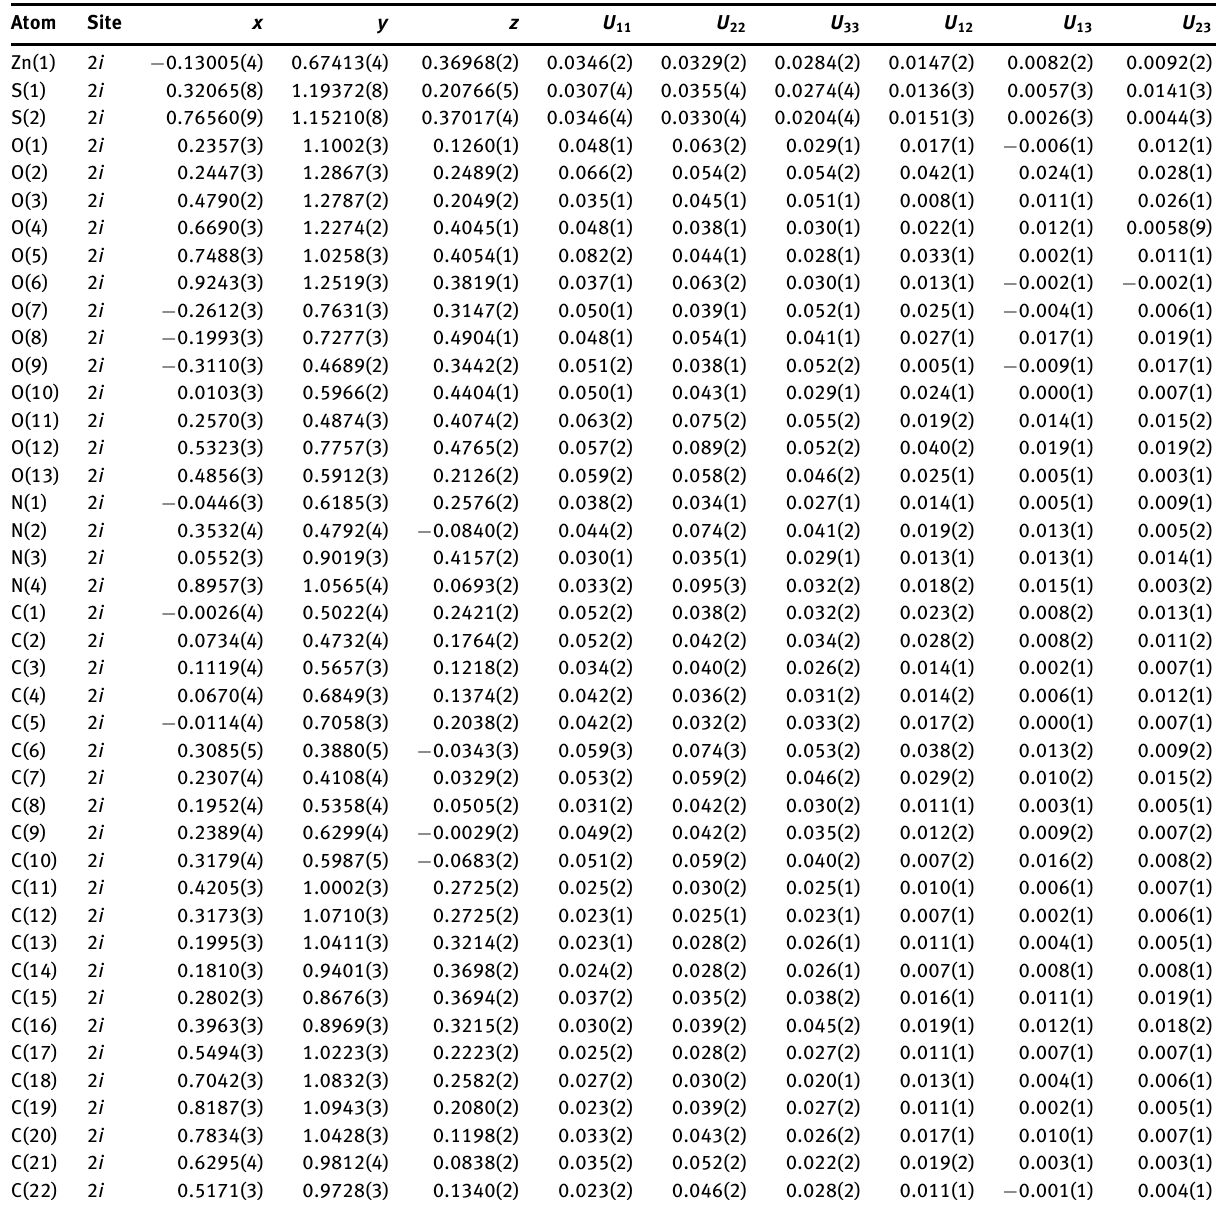
Table 3: Atomic coordinates and displacement parameters (in Å 2